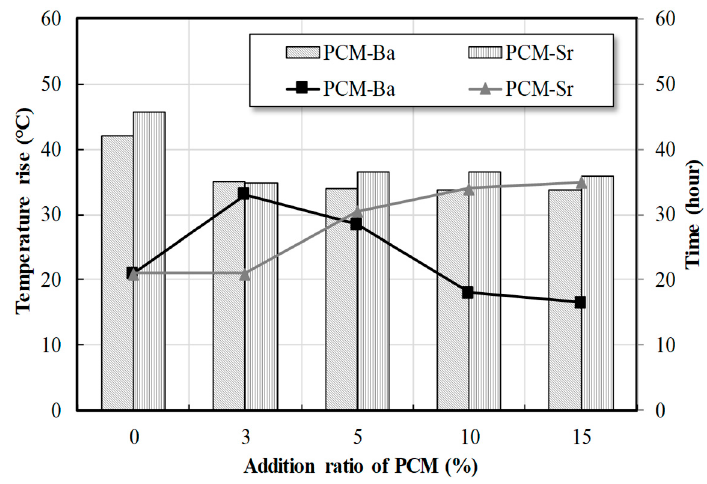
Figure 11. Effects of addition mix ratio of PCM on hydration heat properties.